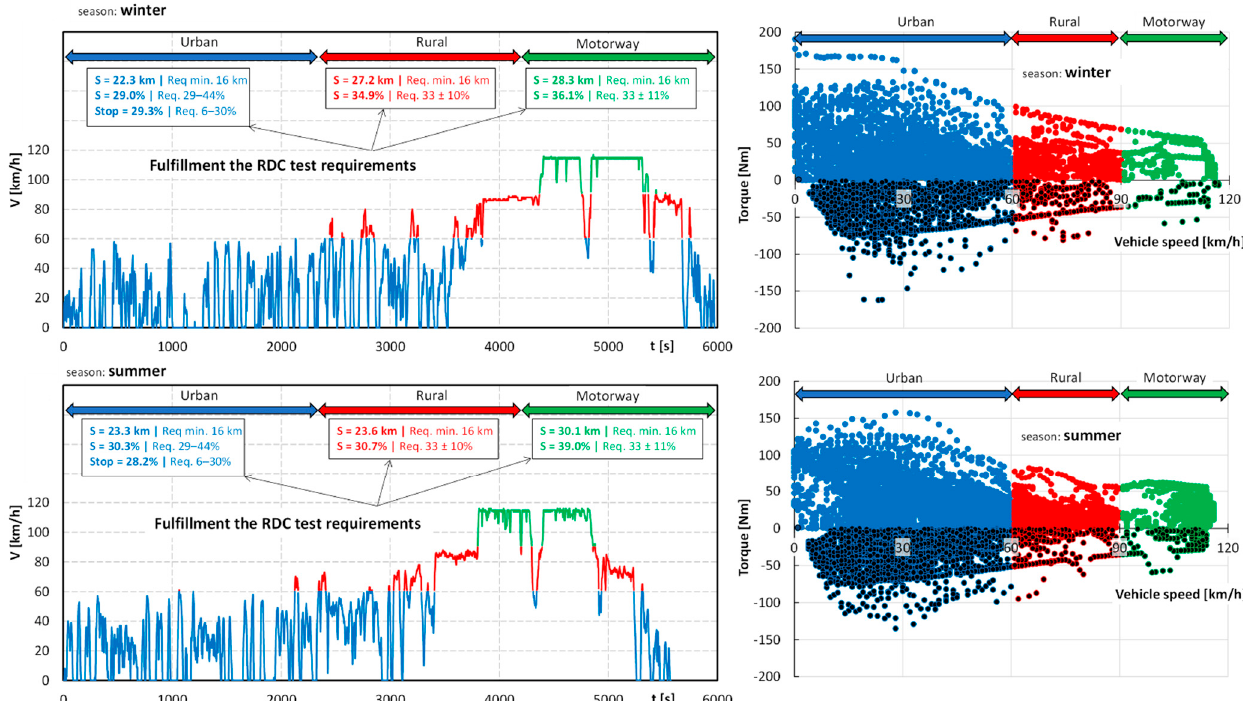
Figure 19. The course of RDC test in summer and winter together with defining basic parameters for meeting test requirements.